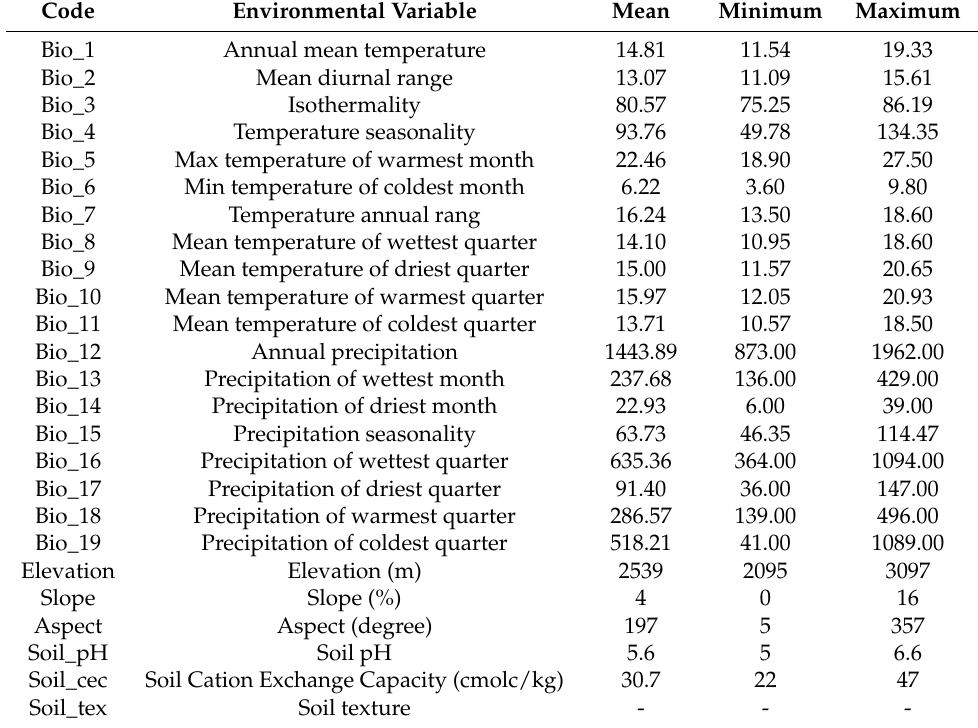
Table 1. Realized niches of highland